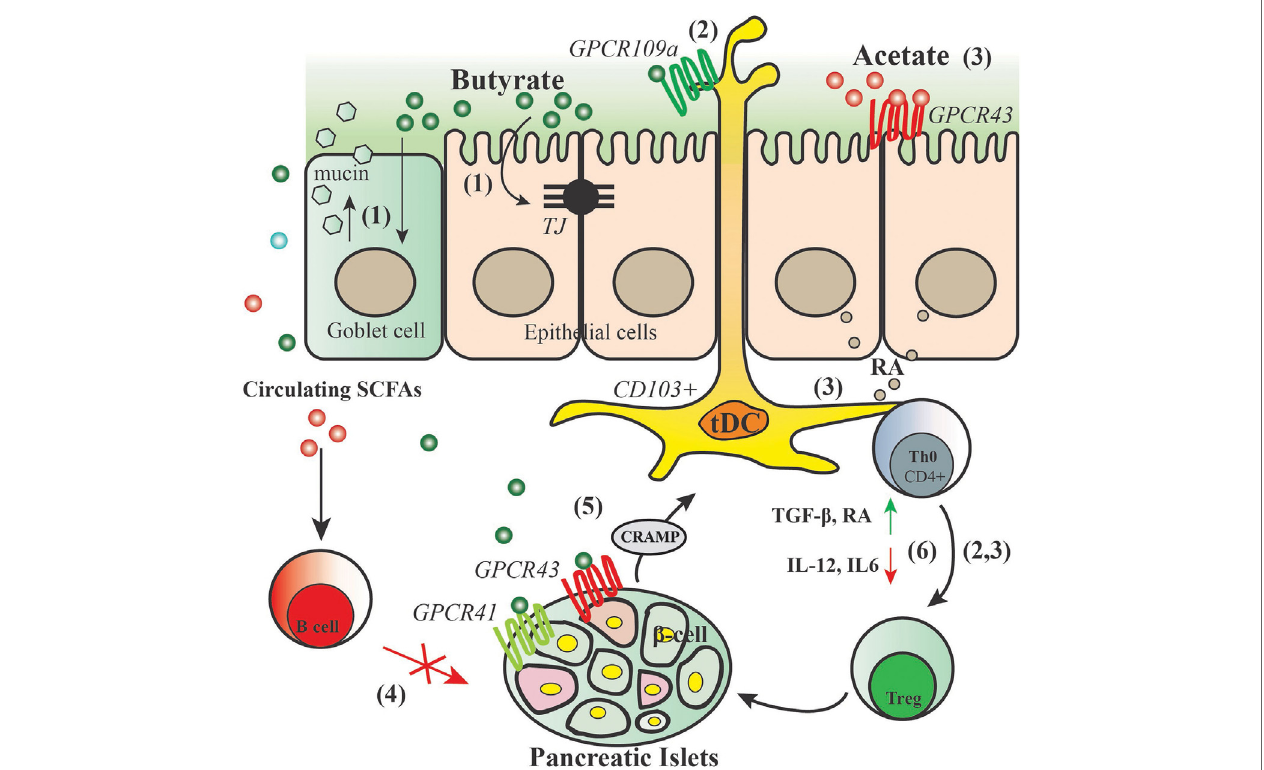
FiGURe 3 | Proposed action for modes of short-chain fatty acids (SCFAs) in the protection of type 1 diabetes. SCFAs generated by gut commensal bacteria in the process of fermentation may have substantial effects on the immune system and intestinal epithelium through different modes of action: (1) butyrate maintains gut integrity by inducing mucin synthesis and TJ production. (2) Butyrate promotes GPCR109a activity, thus inducing CD103 + DCs that promote the proliferation of functional regulatory T cells (Tregs). (3) Acetate activates GPCR43 signaling on the intestinal epithelial cells thus promoting their production of retinoic acid (RA), RA leads to increased ALDH activity in mesenteric lymph nodes CD103 + DCs and a concomitant increase in regulatory T cells. (4) Acetate reduces marginal zone B cells and therefore reduces expansion of islet-autoantigen-reactive T cell. (5) Butyrate binds to GPCR41 and GPCR43 thus controlling the production of cathelicidin- related antimicrobial peptide (CRAMP) by pancreatic β -cells; CRAMP promotes the induction of pancreatic regulatory DCs and generation of pancreatic FoxP3 + Tregs. (6) SCFAs dampen diabetes-related inflammatory cytokines and induce regulatory cytokines and mediators that lead to induction and expansion of